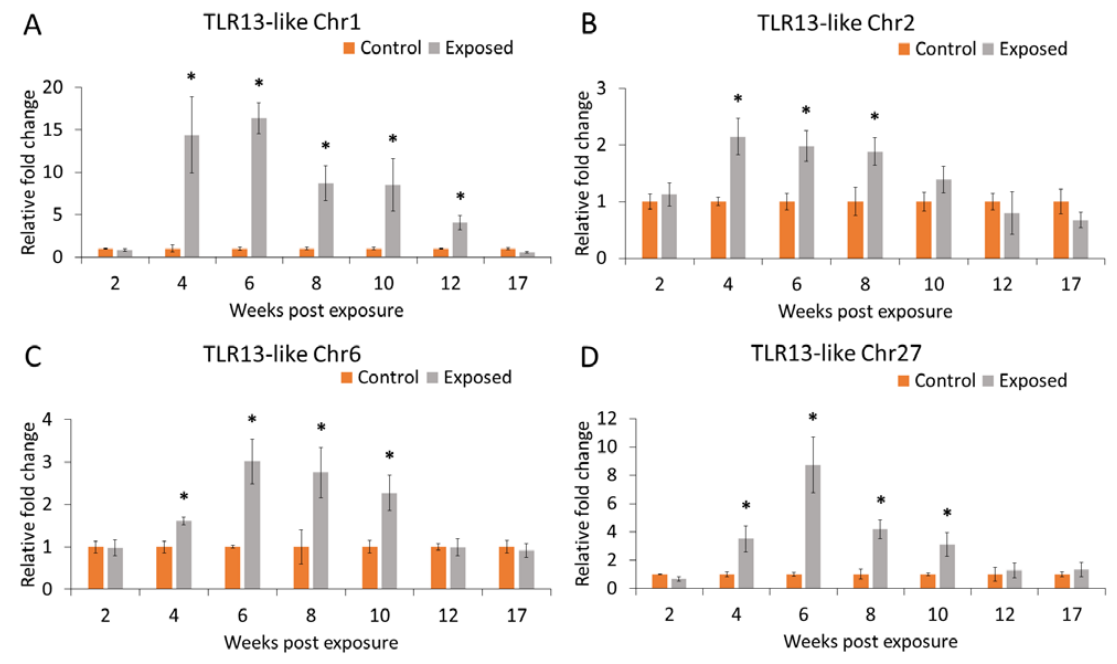
Figure 7. Relative expression of TLR13-like genes in the posterior kidney of brown trout. ( A ) Expression profile of TLR13-like Chr1. ( B ) Expression pattern of TLR13-like Chr2. ( C ) Expression pattern of TLR13-like Chr6. ( D ) Expression pattern of TLR13-like Chr27. Significant differences in the mRNA expression between the exposed and control groups at each time points are indicated with an * ( p < 0.05). Each bar shows the mean ± SEM ( n = 9).